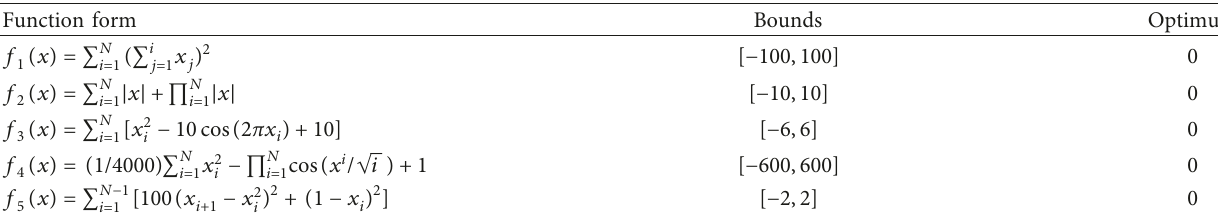
Table 2: Test function.